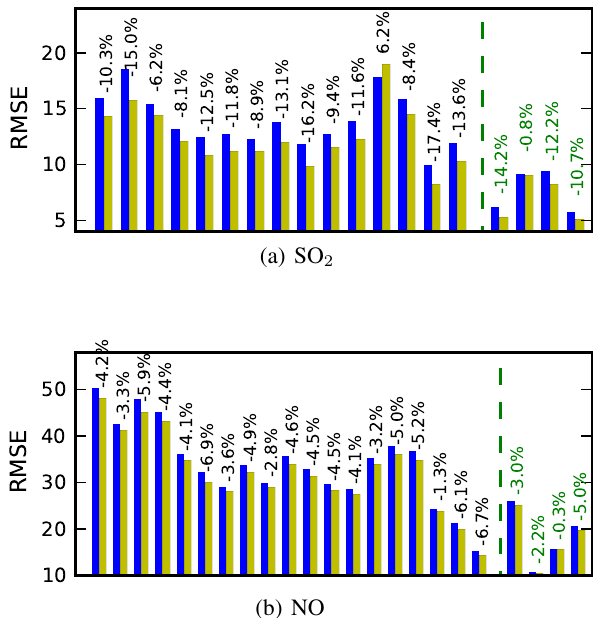
Fig. 5. RMSE (µg m − 3 ) at stations for the whole period (April–September), for reference model (blue, first bar) and plume-in-grid model with similarity theory (yellow, second bar). The difference between the plume-in-grid and reference RMSE is indicated above the bars for each station, in percent. The first group of bars is for urban stations (percent indicated in black), the second group is for periurban and rural stations (percent in green).